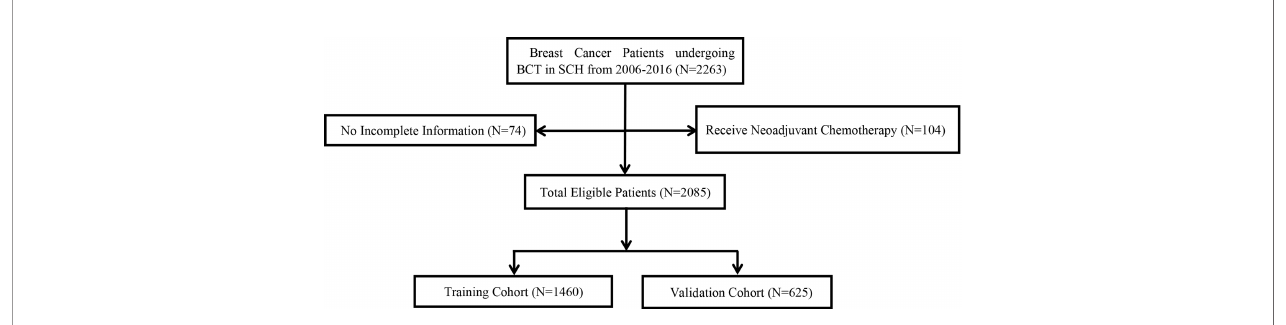
FIGURE 1 | Consort diagram for the study cohort. BCT, breast cancer therapy; SCH, Shandong cancer hospital; LRR, local – regional